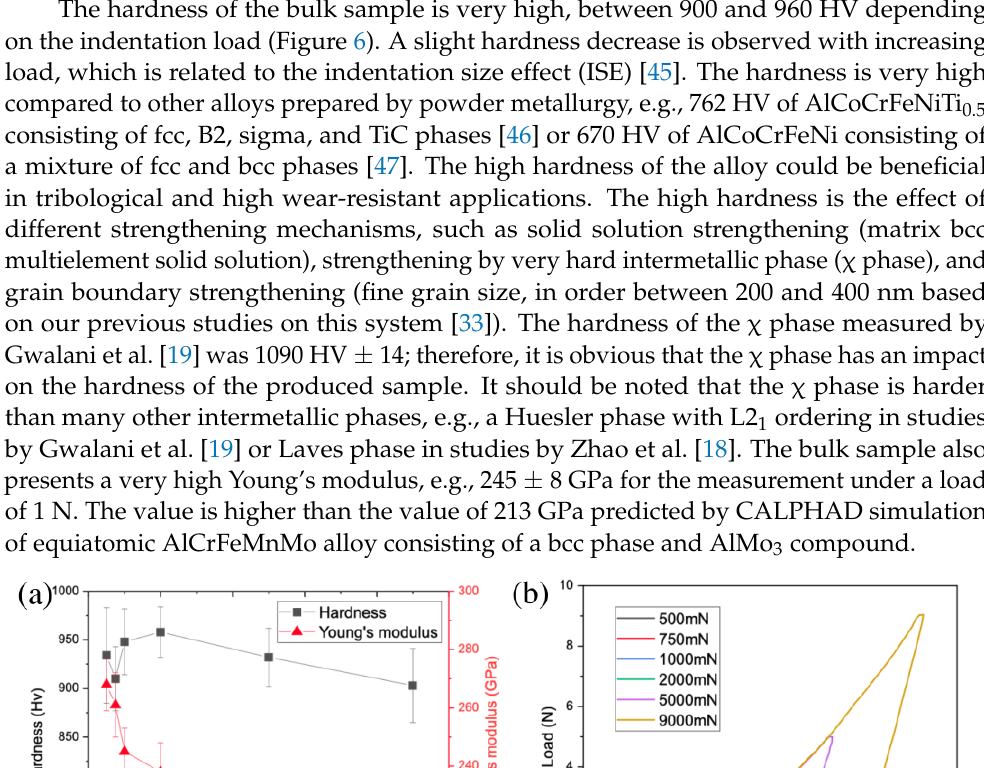
Figure 7. SEM secondary electron image of the indentation site showing circumferential cracks with- out the presence of radial cracks. 4. Conclusions Non-equiatomic HEA from the Al-Cr-Fe-Mn-Mo family was successfully prepared via powder metallurgy. The mechanically alloyed powder consists of two bcc phases. An- nealing at 950 °C for 1 h led to the phase transformations. As a result, it was determined that the powder consists of a predominant bcc phase (71 ± 2% ), intermetallic χ phase ( 27 ± 2%), and small volume fraction (1 ± 1%) of M 6 C and M 23 C 6 . The bulk sample presents a similar microstructure with a higher volume fraction of carbides in the area close to the surface due to the diffusion of carbon from the graphite die during sintering. The main finding of this paper is the presence of the χ phas e in the bcc matrix in the multicomponent alloy. The intermetallic χ phase is very rarely reported in HEA, but it can significantly improve the hardness. It can open new perspectives on research into multicomponent al- loys with a hard χ phase. The very high hardness and Young’s modulus of the investi- gated bulk sample 948 ± 34 HV 1N and 245 ± 8 GPa, respectively, show the need to investi- gate this HEA system further. Future studies should focus on the investigation of the wear